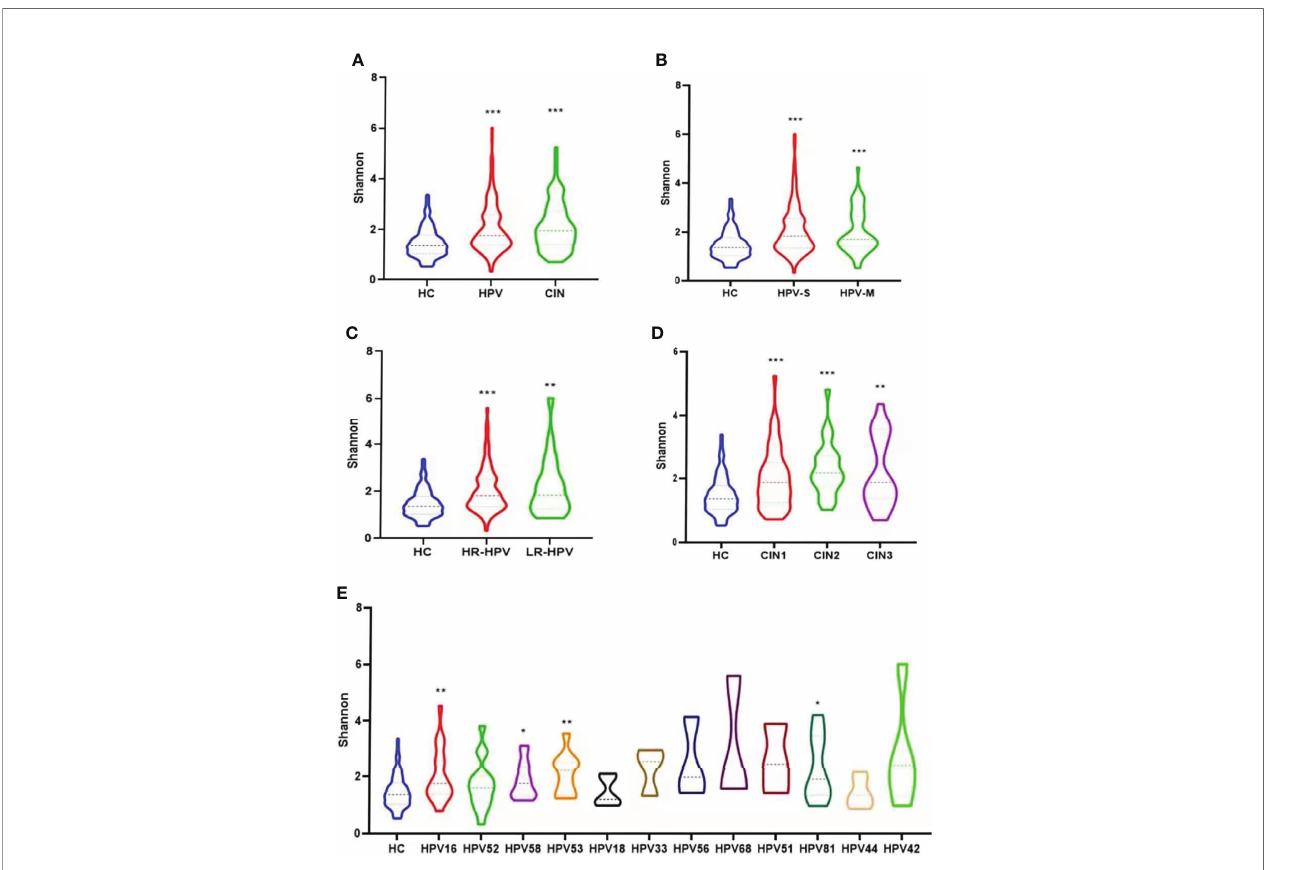
FIGURE 3 | Microbial alpha diversity analysis based on Shannon index. (A) Microbiota diversity (Shannon) comparison among groups of healthy control women, HPV-infected women and CIN-diagnosed women (Wilcoxon one-side test; ***p < 0.0001). (B) Microbiota diversity comparison of healthy control group, and groups infected with single and multiple HPV types (Wilcoxon one-side test; ***p < 0.0001). (C) Microbiota diversity comparison of healthy control group, and groups infected with high-risk (HR) and low-risk (LR) HPV types (Wilcoxon one-side test; **p < 0.005 and ***p < 0.0001). (D) Microbiota diversity comparison of healthy control group, and groups diagnosed with CIN1, CIN2, and CIN3 (Wilcoxon one-side test; **p < 0.005 and ***p < 0.0001). (E) Microbiota diversity among participants infected with different HPV types in comparison with healthy women (Wilcoxon one-side test; *p < 0.05 and **p <